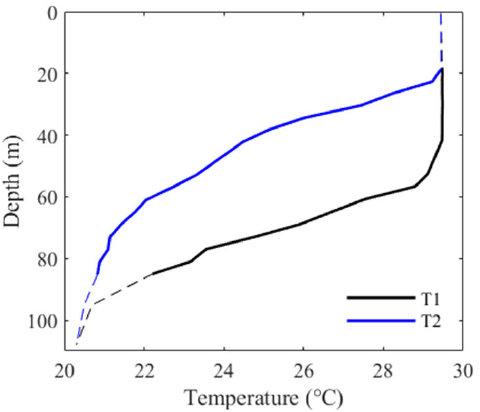
Figure 4. Temperature versus depth measured at different times. The solid curves are from the data of VLA TD sensors, and the dashed curves are added using the data of the XCTD probe.